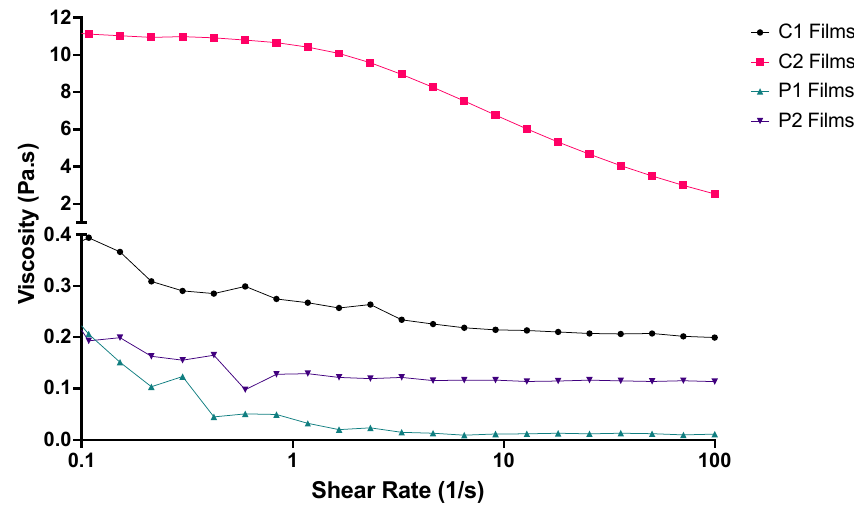
Figure 2. Rheological profiles of the four ODF polymer solutions used for 3D printing the films ( n = 3) .